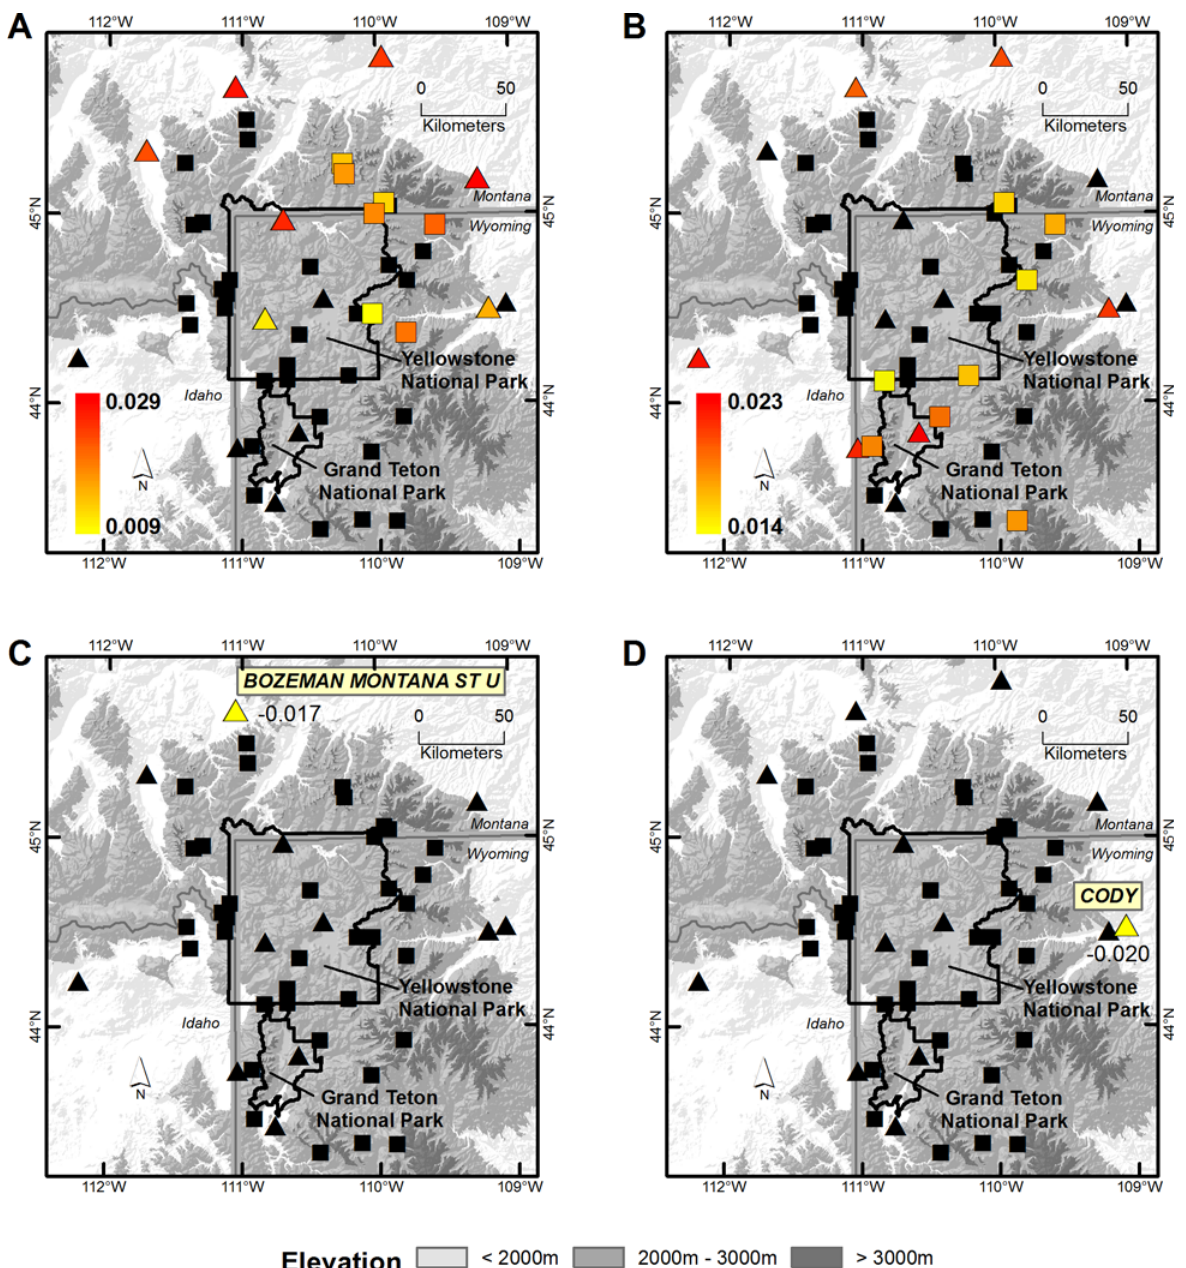
Fig 2. Annual trends in minimum and maximum temperatures for Spring and Fall. Trends in the mean minimum (A, C) and maximum (B, D) temperatures for the Spring (A, B) and Fall (C, D) at SNOTEL ( □ ) and COOP weather station sites ( Δ ) in the Greater Yellowstone Area using the modeled SNOTEL + COOP data, 1948 – 2012. Trend magnitude is indicated in the legend with warmer colors indicating larger trends. Sites where the trend did not differ from zero are filled in black. For Fall, the trend estimate and site name is indicated adjacent to the sites filled in